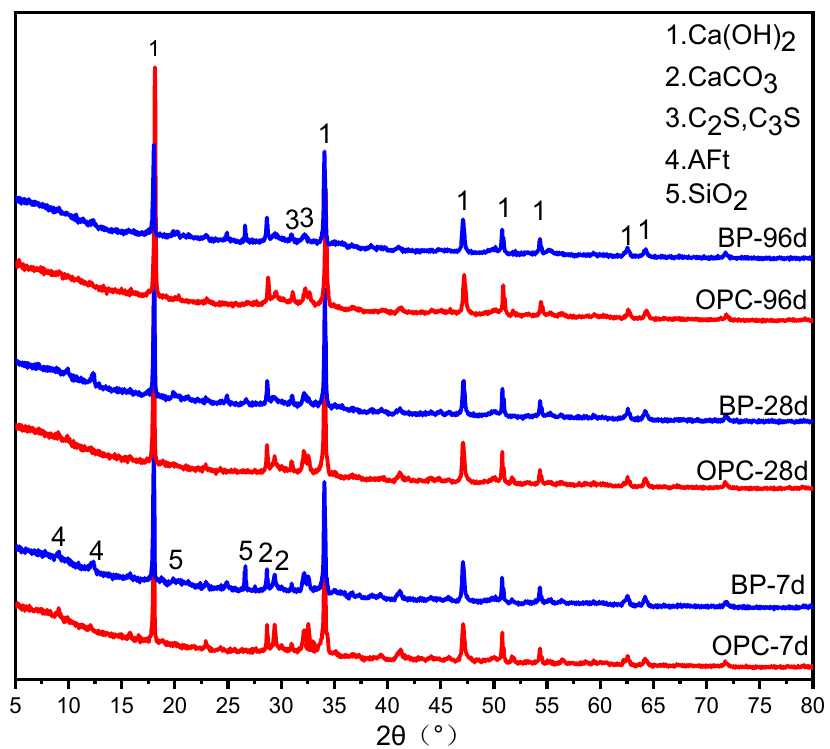
Figure 8. XRD patterns of OPC paste and BP paste at 7, 28, and 96 d. Phase identified: Ca(OH) 2 , PDF No. 84-1263; CaCO 3 , PDF No. 86-0174; C 3 S, C 2 S, PDF No. 73-0599; AFt, PDF No.41-1451; SiO 2 , PDF No.85-0798.